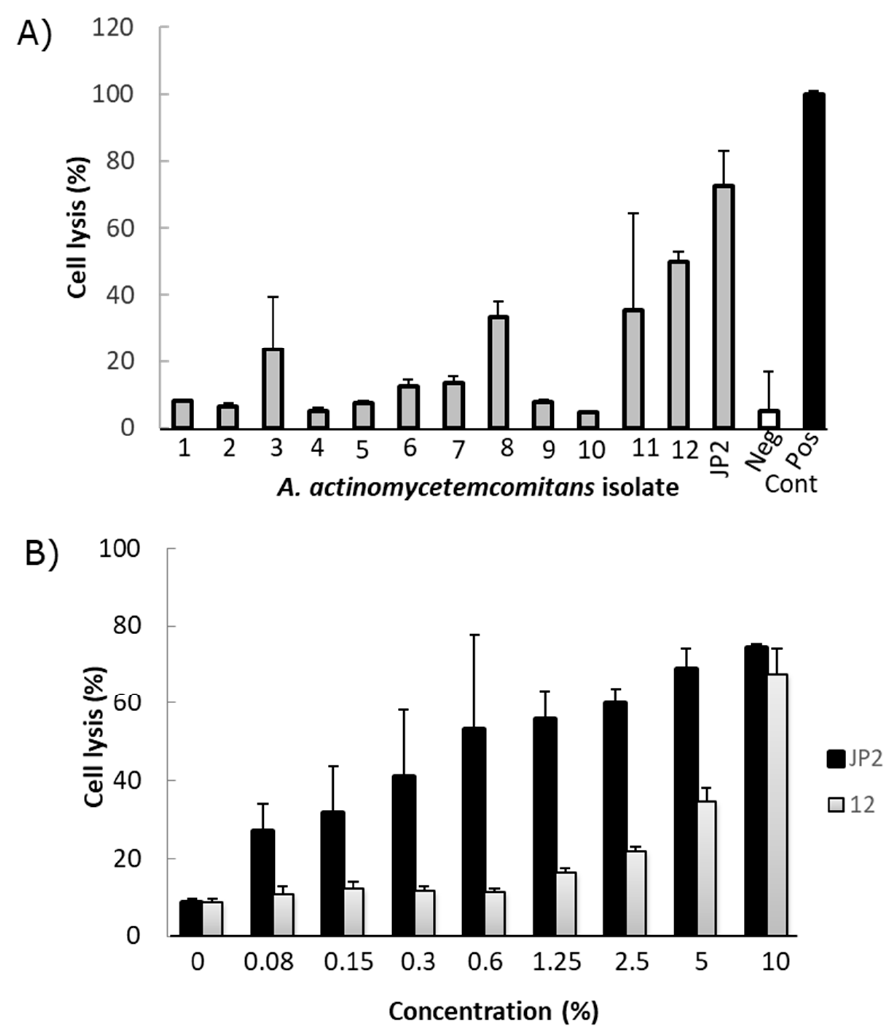
Figure 5. Leukotoxic activity of extracts from 12 different isolates of A. actinomycetemcomitans and a JP2 genotype strain of A. actinomycetemcomitans as comparison. ( A ) Effect on cell lysis in cultures of THP-1 cells exposed for 2 h. Gray bar is test bacteria, white bar is negative control and black bar is cell lysate. ( B ) Dose-dependent leukotoxicity in cultures of THP-1 cells exposed for 2 h in extract from isolate 12 (grey bars) and the JP2 genotype (black bars) of A. actinomycetemcomitans . Mean ± SD of triplicate analyses.